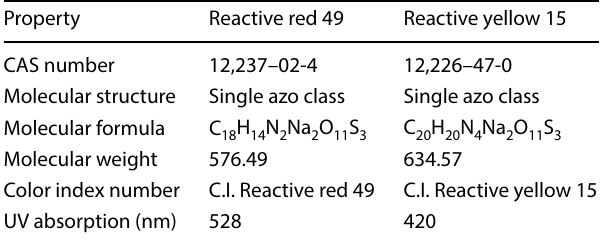
Table 1 The Chemical structure and characteristics of studied dyes Property